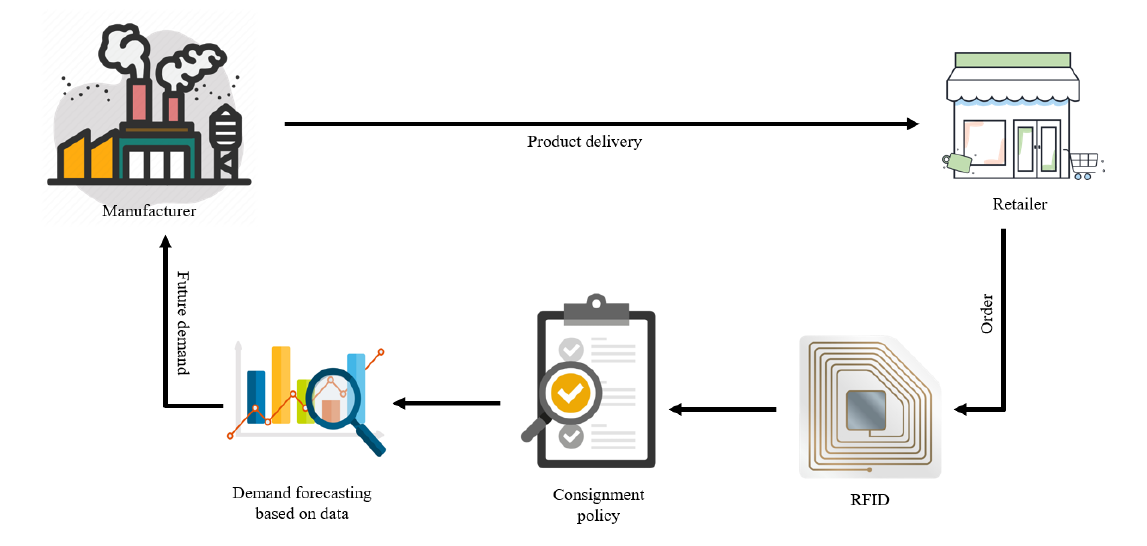
Figure 2. Demand forecasting over the ML-RFID